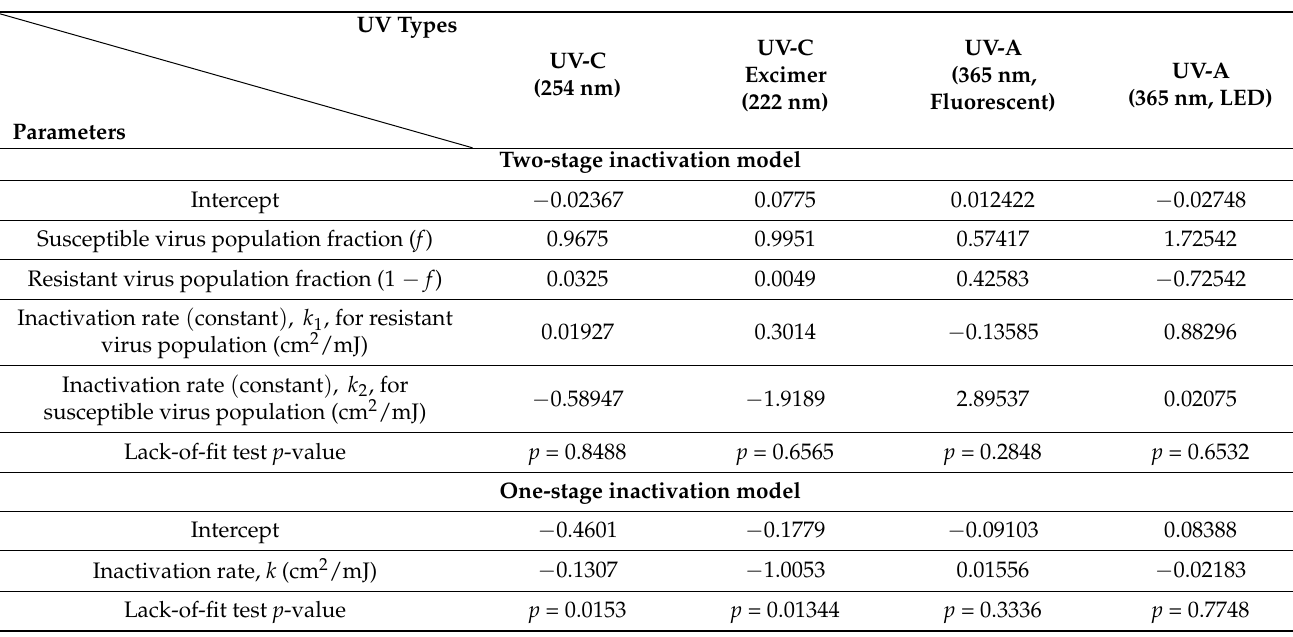
The corrected Table 2 is: Table 2. One-stage and two-stage models, parameter estimations, and model parameters for inactiva- tion of airborne PRRSV with four types of UV light